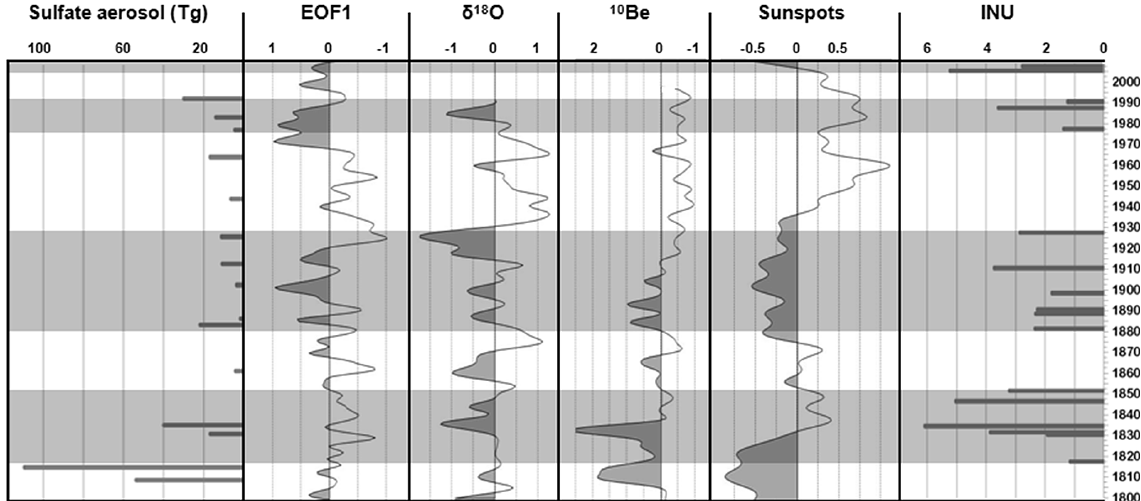
Figure 9. Temporal evolution of INU (INU >1.5SD), the volcanic eruptions and the standardized anomalies of EOF1, δ 18 O, 10 Be and sunspots for the period 1800–2009. All series are plotted as normalized values smoothed with an 11-year low-pass Gaussian filter, except the sunspot number record smoothed with a 22-year filter. The volcanic eruptions and INU index are unsmoothed. Periods of high flood frequency are marked on the chart. Note that the δ 18 O and sunspot scales are reversed.